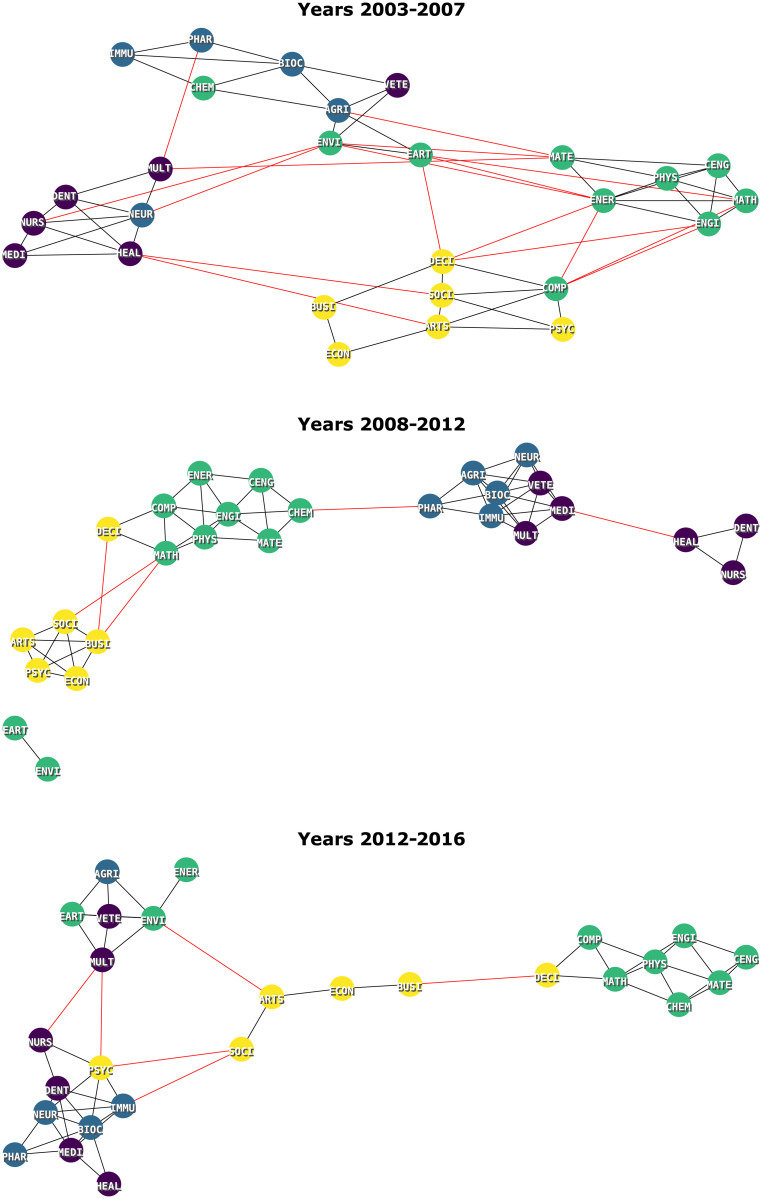
Backbone network.Backbone with α = 0.20 of the space created by the embedding model for the intermediate areas, for different time intervals. The color of the edge represents whether it is inter-group (red) or intra-group (black). The color of the vertex represents the associated macro area.